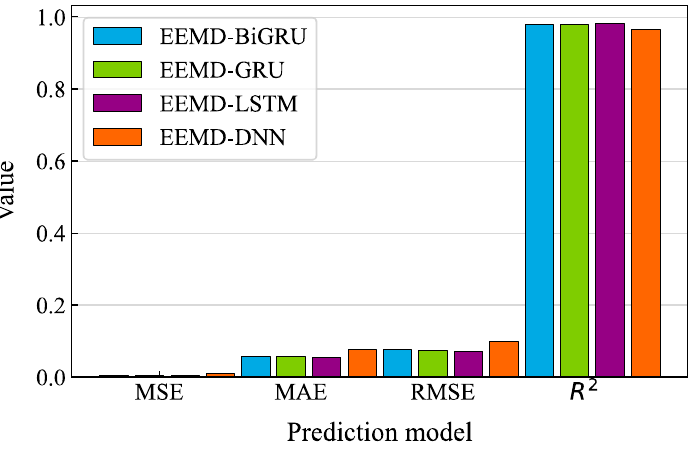
Figure 13. Comparison of the four evaluation metrics of the different EEMD-based models.